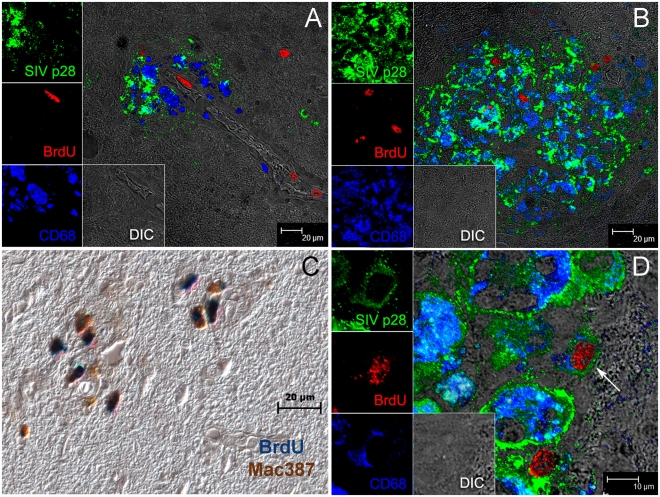
The majority of BrdU+ monocyte/macrophages in the brain are not productively infected.Triple label with antibodies against BrdU (red), SIV p28 (green), CD68 (blue) is used to determine if BrdU+ cells are productively infected. Side panels are single-color images of SIVp28 (green), BrdU (red), CD68 (blue) and differential interference contrast (DIC). A: BrdU+ (red) cells in blood vessels and a BrdU+ cell infiltrated in the brain B–D: Multiple BrdU+ cells are detected in and around SIVE lesion. B: BrdU+ cells are seen in and around this SIVE lesion; the majority BrdU+ cells are SIV p28− and thus not productively infected. C: The majority of the BrdU+ cells in lesions are Mac387+. Double label with antibodies against BrdU (blue) and Mac387 (brown) in an SIVE lesion is shown. D: An SIVE lesion in the brain of a rapid progressor showing a rare triple positive cell: SIV-infected CD68+BrdU+ macrophage (white arrow). Data presented here are representative of n = 3 macaques with SIVE. Multiple tissue sections from different brain regions were examined.